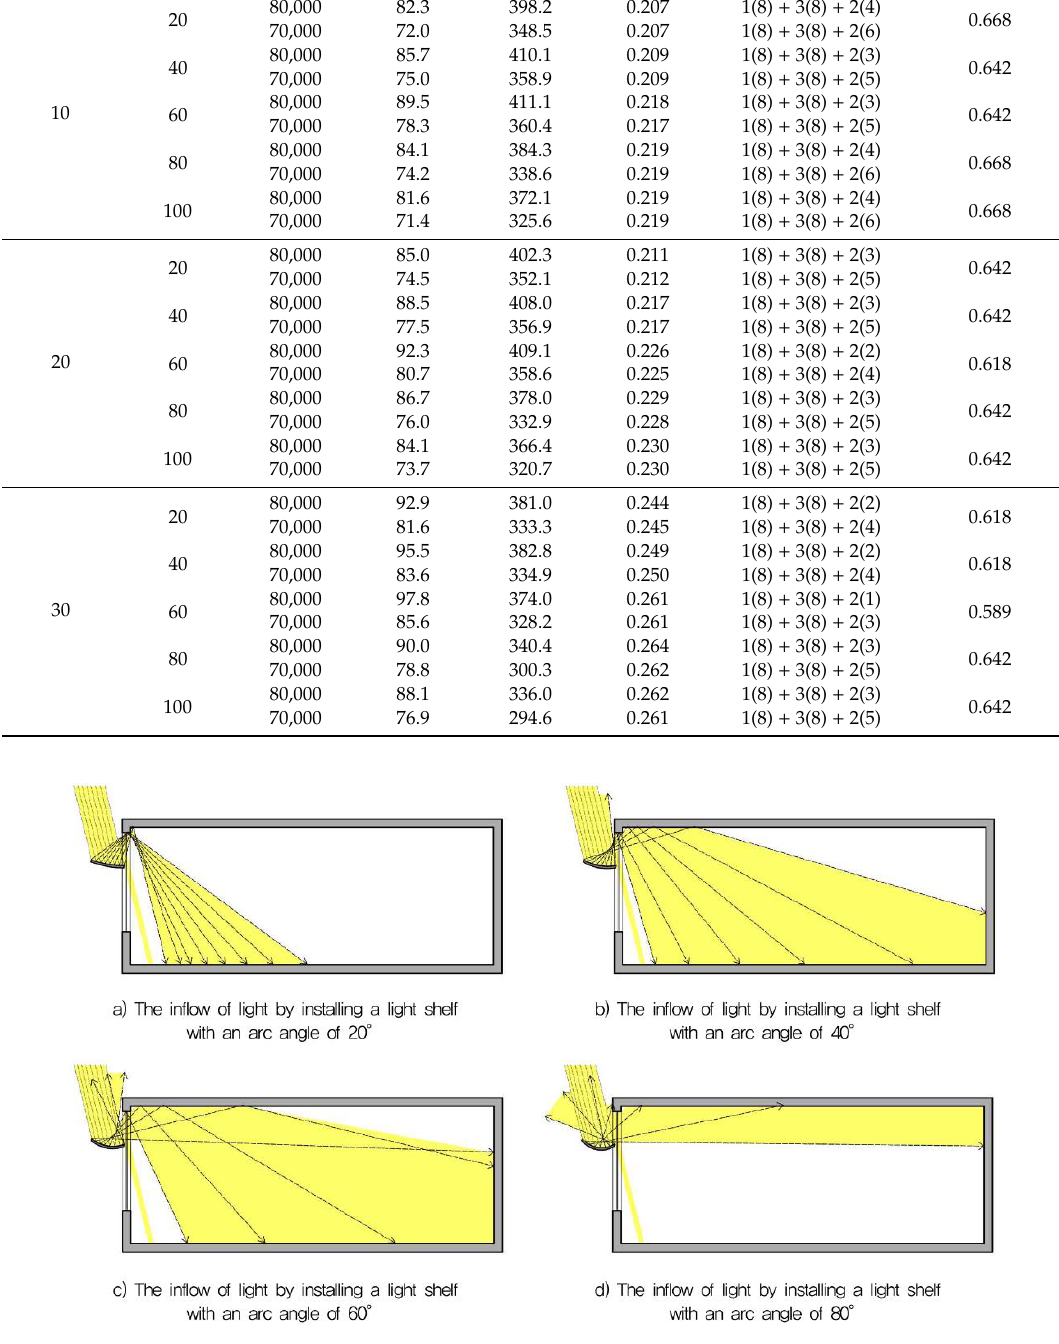
Figure 13. Inflow of light achieved by a curved light shelf during summer depending on the arc angle.